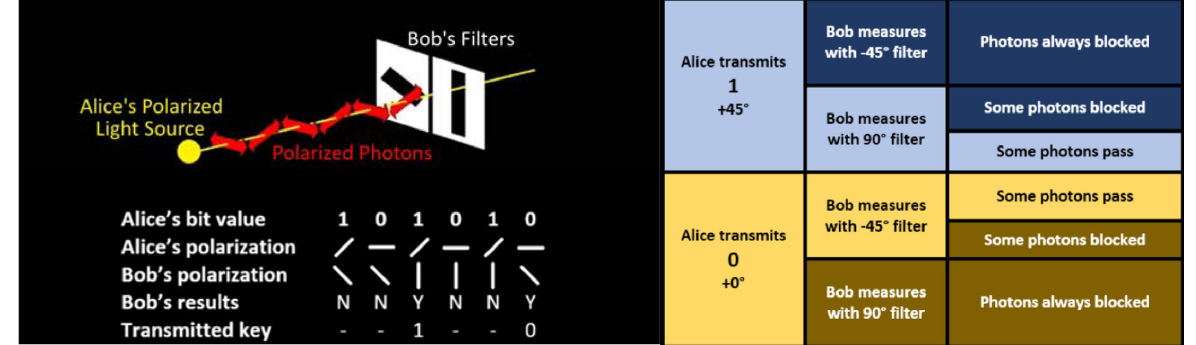
FIG. 2. In the QKD QuILT, students are first asked to make predictions about what should happen in a given situation and later asked to check whether their predictions are consistent with the information in this figure about the QKD protocol involving nonorthogonal polarization states of single photons. Students are then asked to reconcile differences between their predictions and what happens in a given situation if their predictions are not consistent with this figure before they